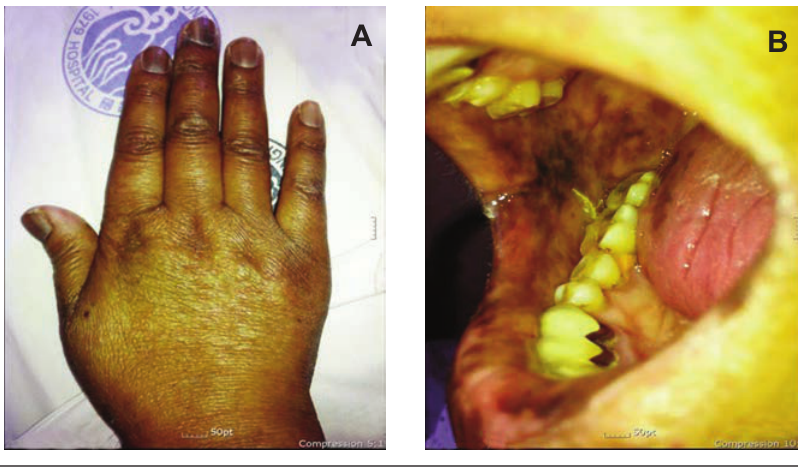
Figure 1. Skin pigmentation in the hands (A), tongue, and buccal mucosa